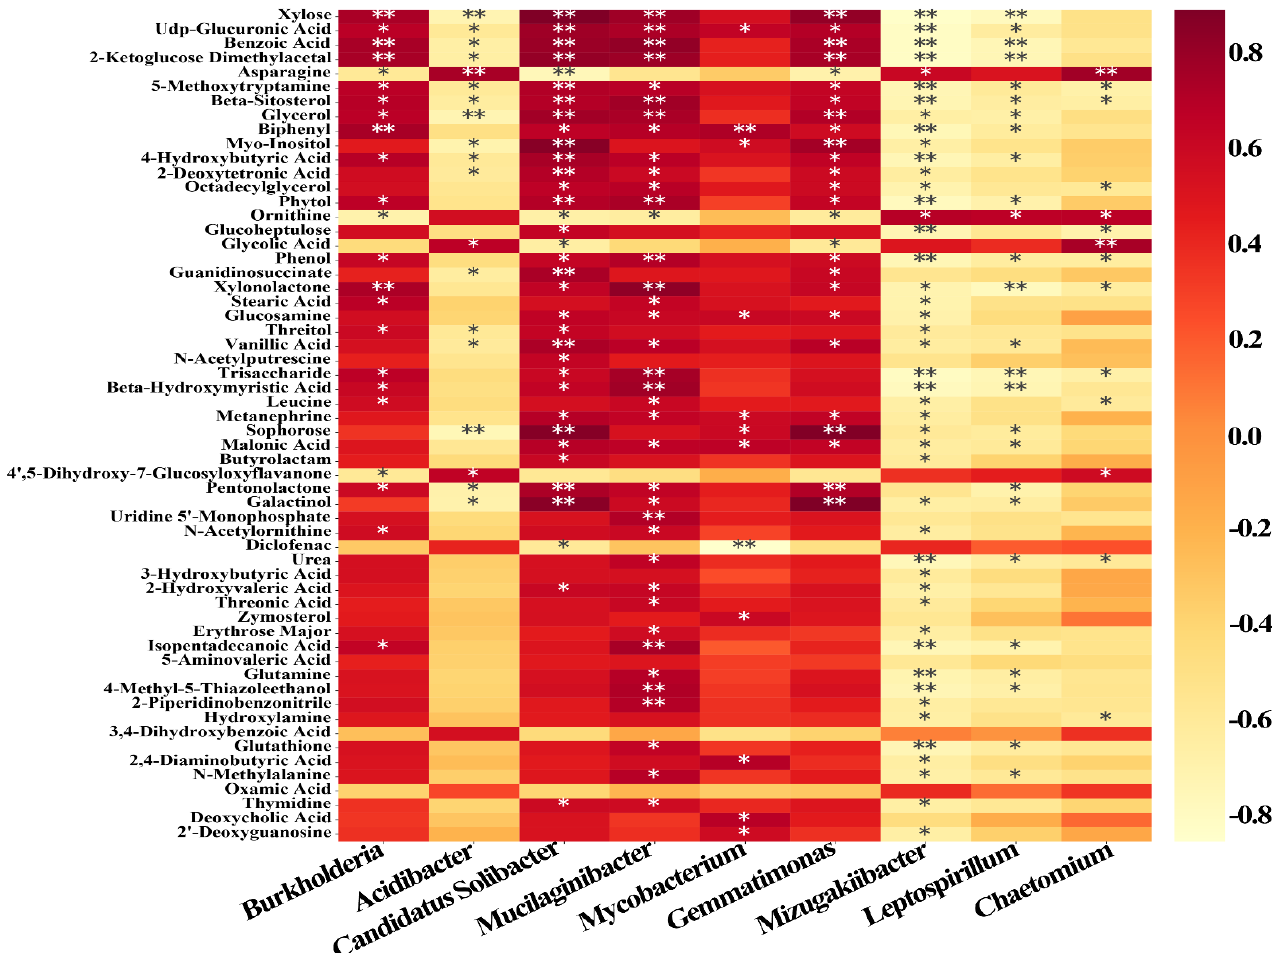
Figure 8. Correlation analysis between the relative abundances of the soil microbiota at the genus level and the metabolite relative contents in the fungicide prochloraz treatment. * and ** mean significance at p < 0.05 and p < 0.01, respectively. The depth of the orange scale indicates the magnitude of the correlation coefficient; the lighter the color is, the greater the negative correlation is, while the darker color is, the greater the positive correlation is.